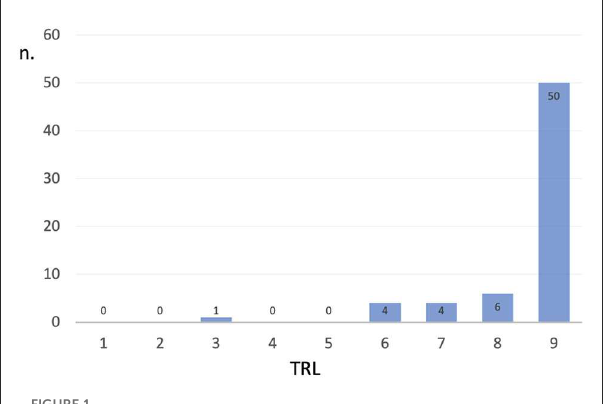
FIGURE1 Distribution of the TRL values for the 75 robots collected in the analysis.